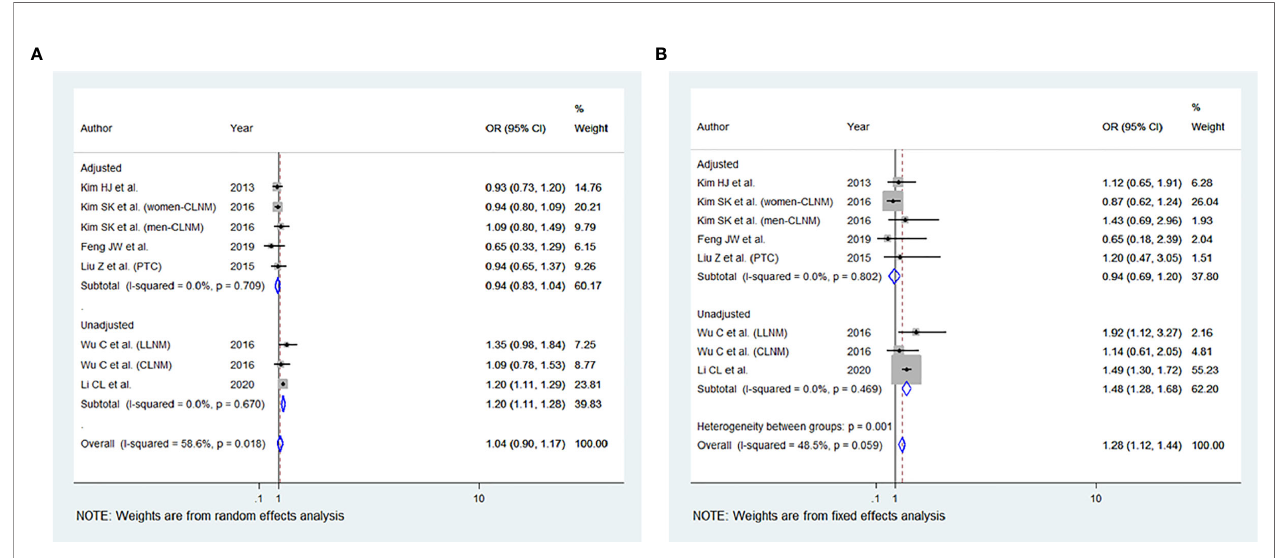
FIGURE 6 | Forest plots for the meta-analysis for the association between Body Mass Index and lymph node (LN) Metastasis. (A) Meta-analysis between overweight and LN Metastasis. (B) Meta-analysis between obesity and LN